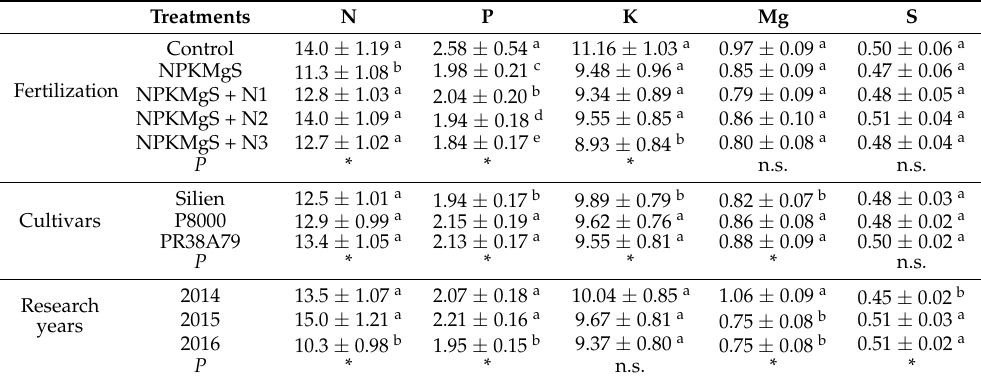
Table 5. The nitrogen, phosphorus, potassium, magnesium and sulphur content in maize biomass (g · kg –1